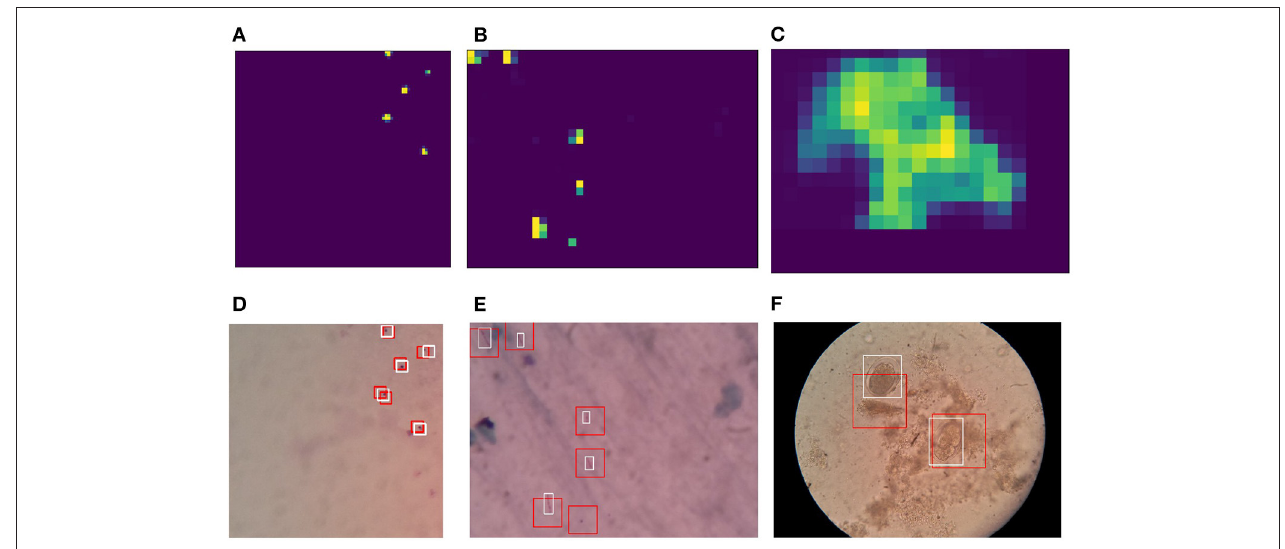
FIGURE 8 | Heatmaps generated based on sliding window-based detections using reduced stochastic binarized neural network (BNN) classifiers: (A) Malaria, (B) tuberculosis, and (C) intestinal parasite. Detections on microscopy sample images: (D) Malaria, (E) tuberculosis, and (F) intestinal parasite. Red box indicates network-based detection, and white box indicates ground truth. The N pre used for training and inference are 32.